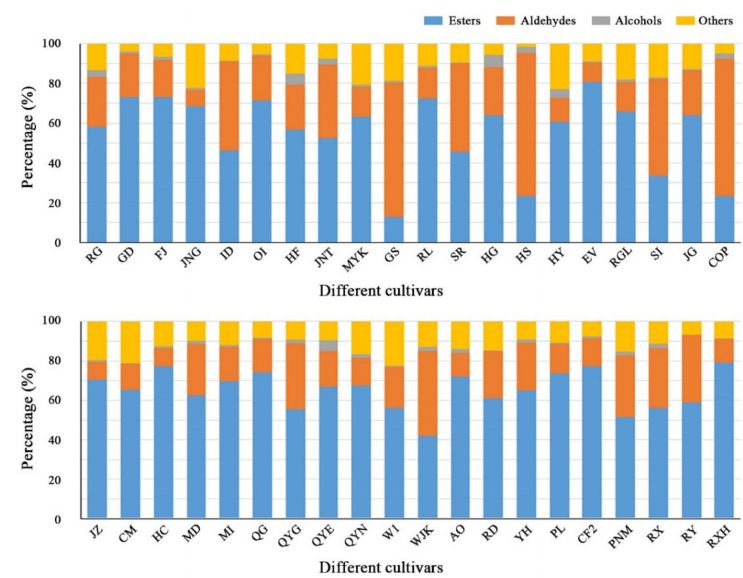
Figure 2. Percentage (%) of each type of volatiles in peels of 40 apple